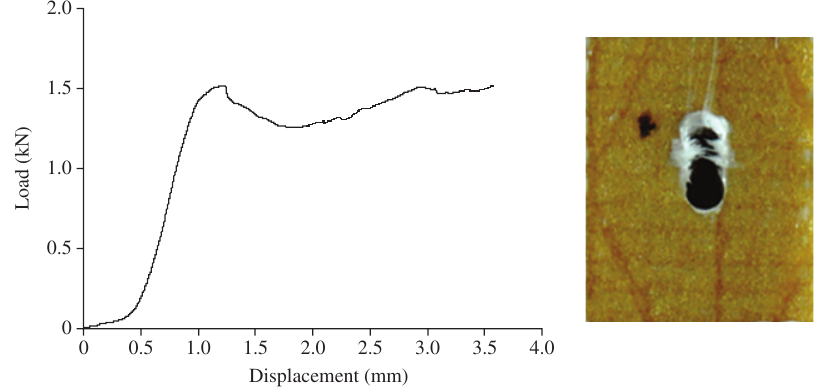
Figure 7 Load-displacement variation and image of the damaged sample for E = 25 mm and D = 6 mm, no potting